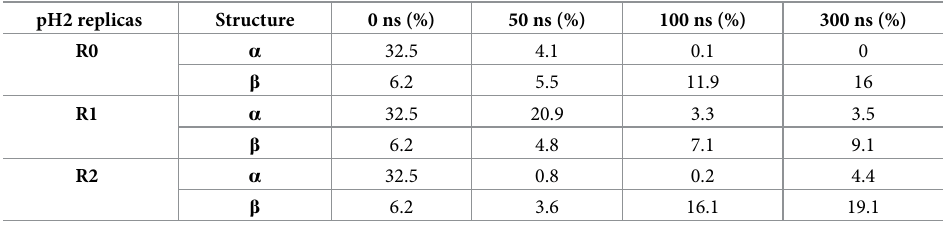
Table 1. The percentage of alpha-helix and beta-strand secondary structures for all simulation replicas at pH 2. pH2 replicas